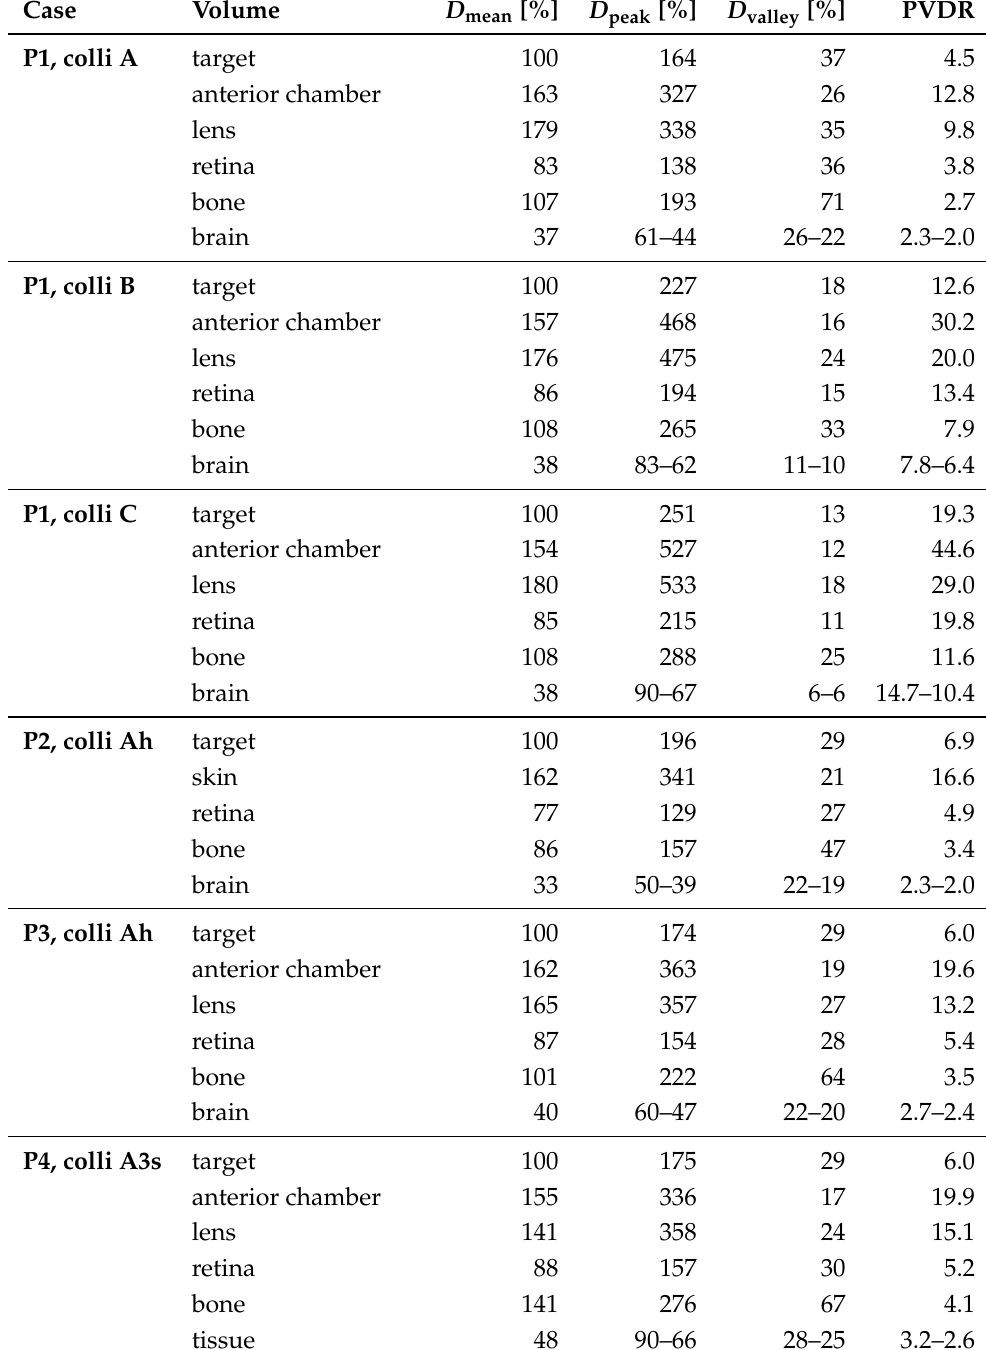
Table 4. Mean, peak and valley doses in the ROI for the different irradiation cases relative to the mean target